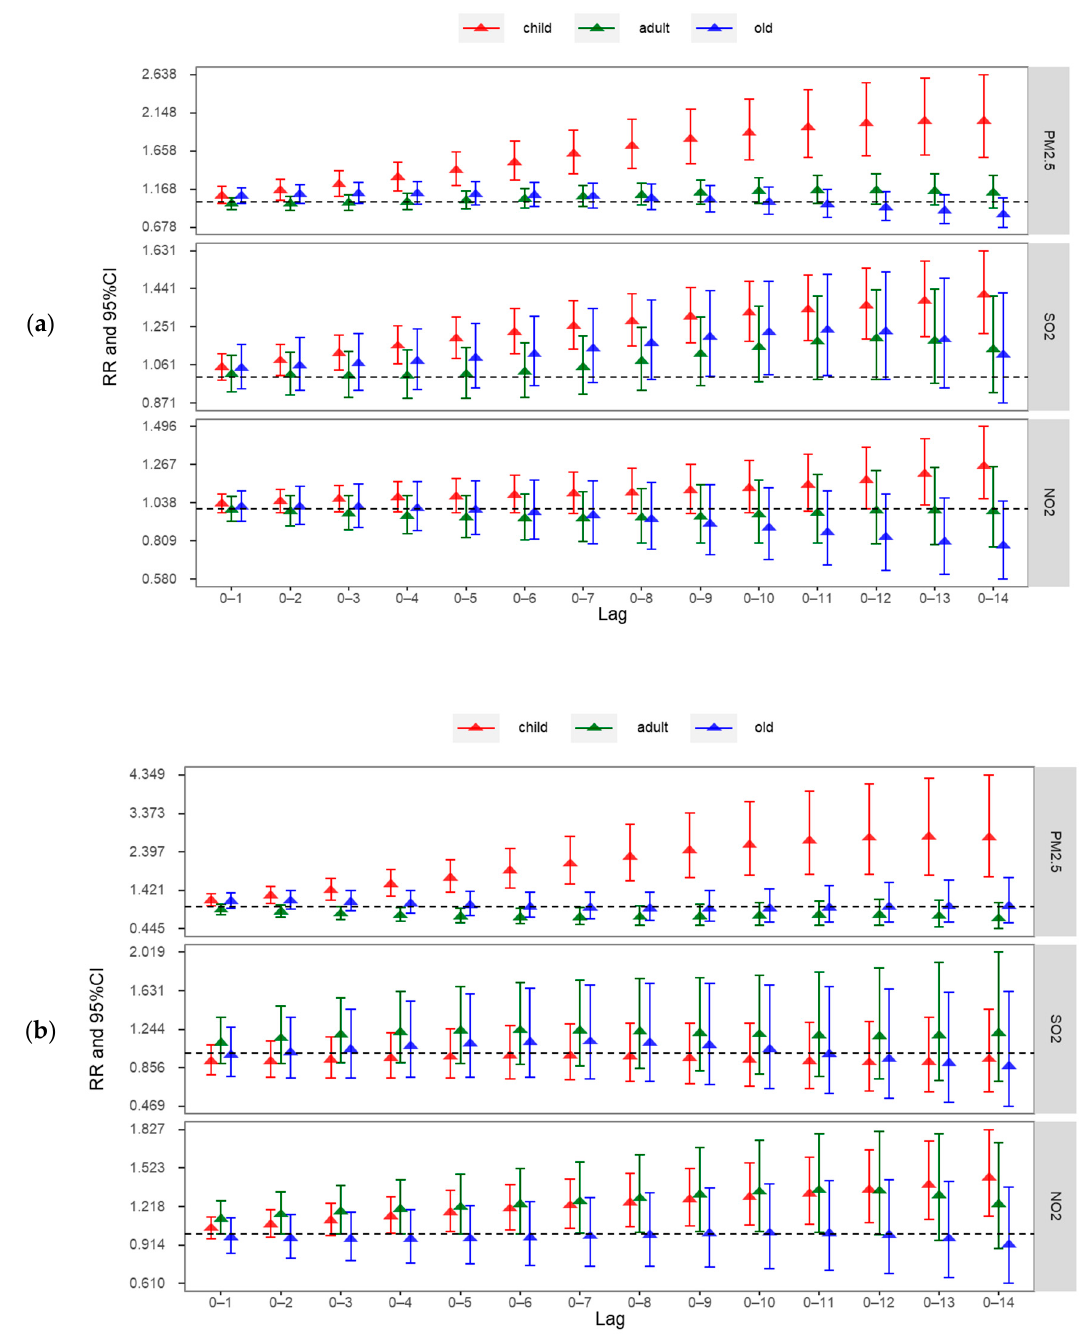
Figure 3. The cumulative lag effects of ambient pollutants on outpatient visits for pneumonia cases by age (child: aged 0–14 years; adult: age 15–64 years; old: age >64 years). Note: After adjusting for long-term trends, day-of-the-week effects, and meteorological factors, the distributed lag nonlinear model (DLNM) was used to obtain the cumulative lag effects, with the first percentile concentration of air pollutants as the reference. Note: ( a ): The moderate levels. ( b ): The high levels. Sensitivity Analysis. We changed the df of the long-term trend (8 to 11 df) to test the stability of the model, and found that the estimated value was stable and the shape of the effect diagram does not change (Figure A1 in Appendix